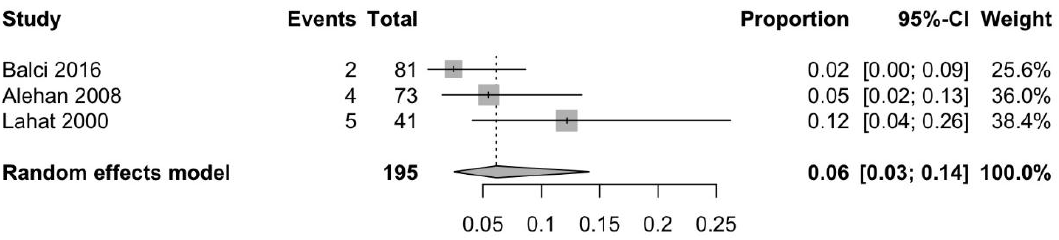
Figure 7. Meta-analysis results as illustrated in the forest plot regarding the odds of having migraine in children with coeliac disease compared to controls.